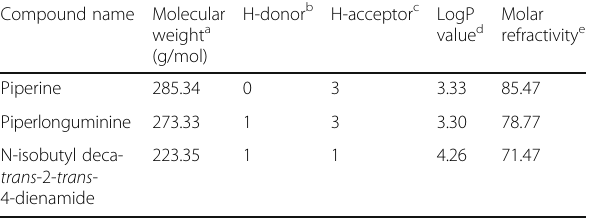
Table 4 Toxicity and ADME analysis of the phytoconstitiuents isolated from Piper sylvaticum by Swiss ADME Analysis and Molinspiration Cheminformatics software Compound name Molecular weight